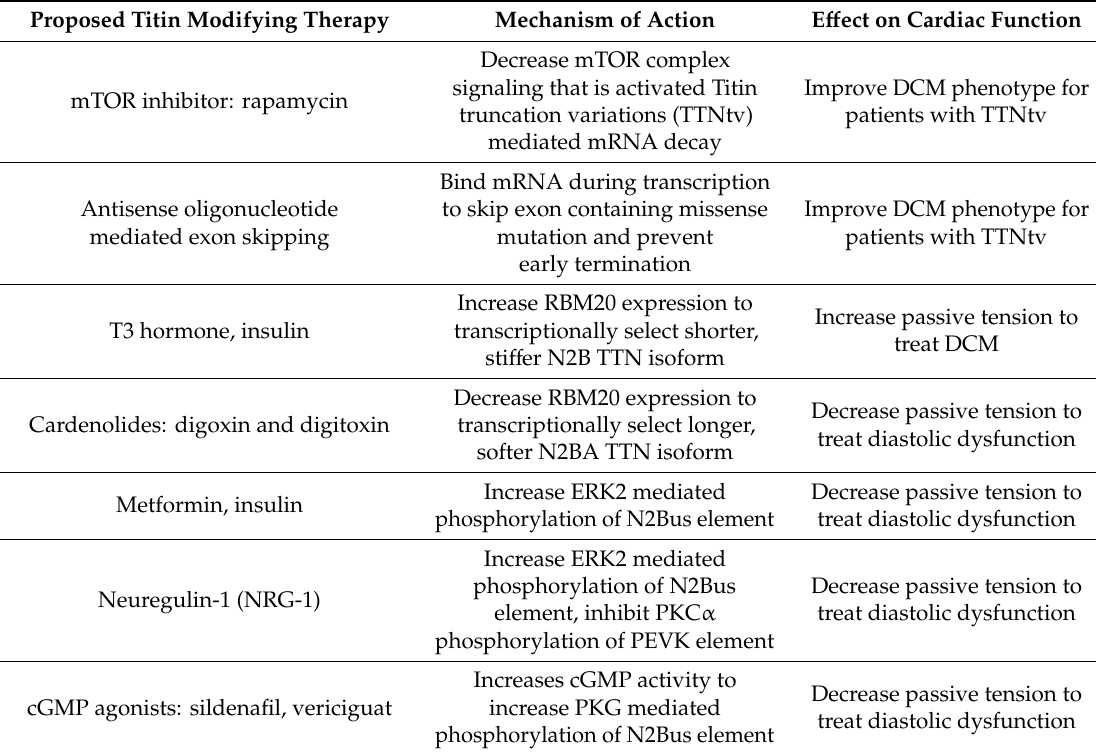
Table 1. Proposed Therapies For Treatment Of Heart Failure That Modify